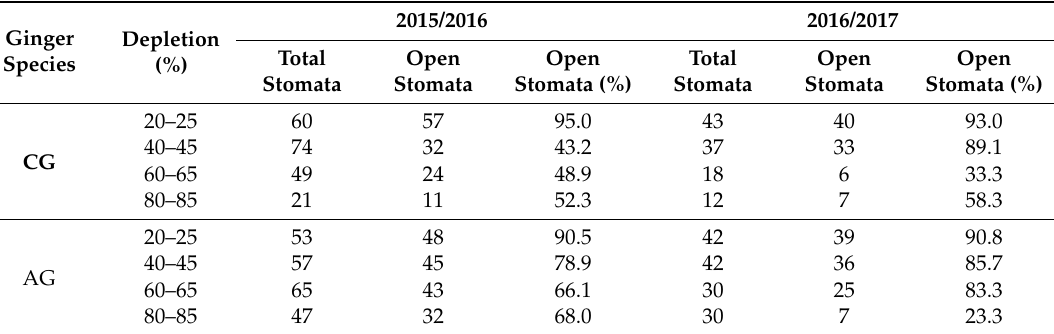
Figure 7. Scanning Electron Microscopy (SEM) images of open stomata of African ginger in response to different irrigation regimes during cropping season 2015/2016. ( A ) AG-20–25% MAD; ( B ) CG-40–45% MAD; ( C ) CG-60–65% MAD; and, ( D ) CG-80–85% MAD. Table 6. Total number of stomata and open stomata per 10 mm 2 in two ginger species, as affected by different irrigation levels in 2015/2016 and 2016/2017.